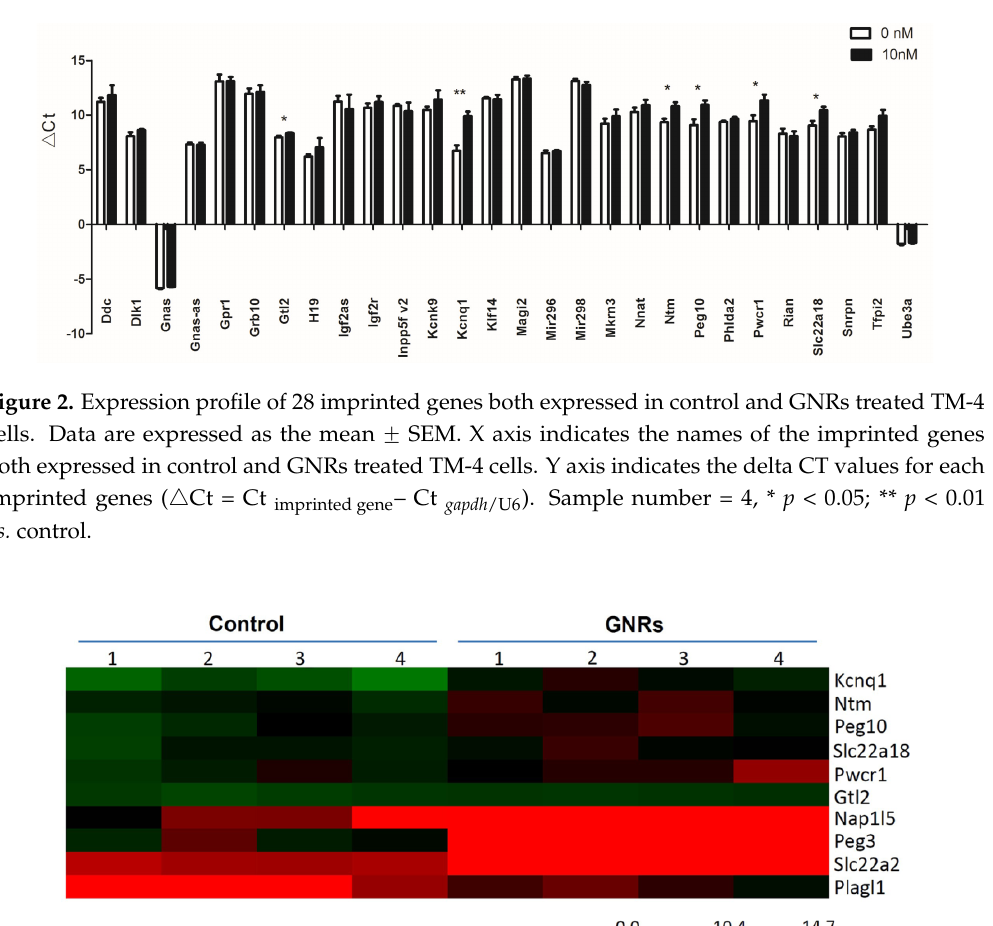
Figure 3. Differentially expressed imprinted genes in control and GNRs treated TM-4 Sertoli cells. The heat map indicates 10 differentially expressed imprinted genes in control and GNRs treated TM-4 Sertoli cells. Y axis indicates the names of the differentially expressed imprinted genes.